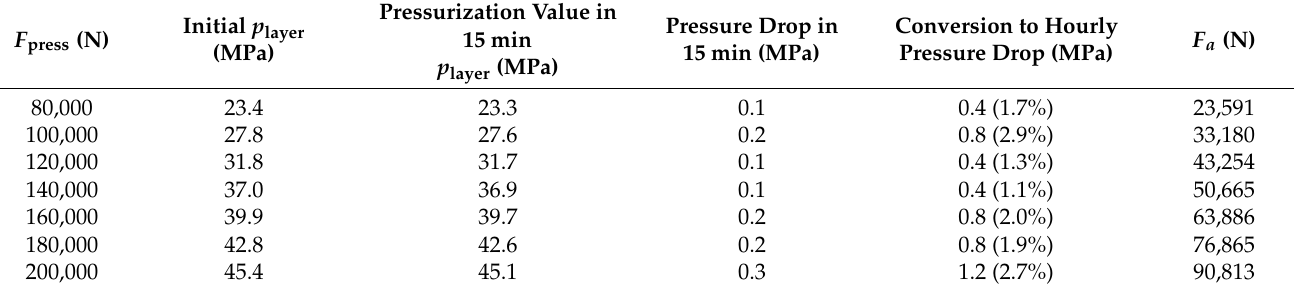
Table 8. Interlayer pressure test data of connector contact sealing theory